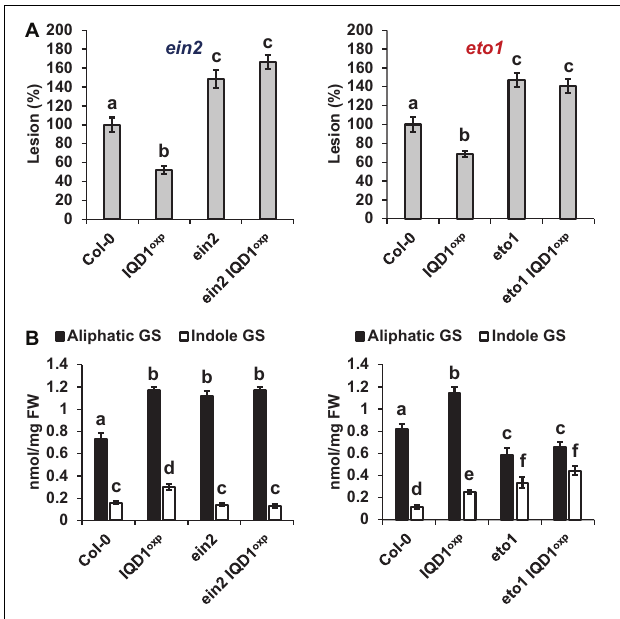
FIGURE 6 | IQD1 OXP effect on ethylene pathway mutants. (A) Detached leaves from 6 week-old Arabidopsis ethylene pathway mutants were inoculated with B. cinerea . Lesion sizes were measured 72 h post-inoculation. Average lesion sizes from 30 leaves of each line are presented along with the standard error of each average. All numbers are presented as the relative percentage to their corresponding background wild-type. Different letters above the columns indicate statistically significant differences at P < 0.05, as determined using Tukey’s honest significant difference test. (B) Glucosinolates were extracted from 6-week old Arabidopsis seedlings of SA pathway mutants and analyzed by HPLC. Mean contents of methionine-derived (black bars) and tryptophan-derived (gray bars) glucosinolates are given for each line. Each column represents an average of eight seedlings with standard error bars indicated. Different letters above the columns indicate statistically significant differences at P < 0.05, as determined using Tukey’s honest significant difference test. Results shown are from a biological replicate, representative of three independent experiments.